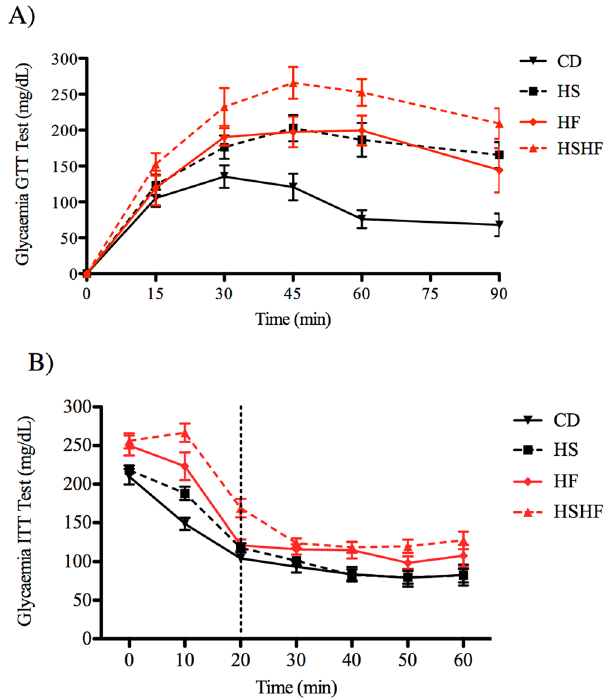
Figure 1. Variations in blood glucose levels during the ( A ) glucose tolerance test (GTT) and ( B ) insulin tolerance test (ITT) in mice fed the control diet (CD) or obesogenic diets (high-sugar (HS), high-fat (HF) or high-sugar/high-fat diet (HSHF) for 8 weeks. The results are expressed as the mean ± S.E.M. (n =